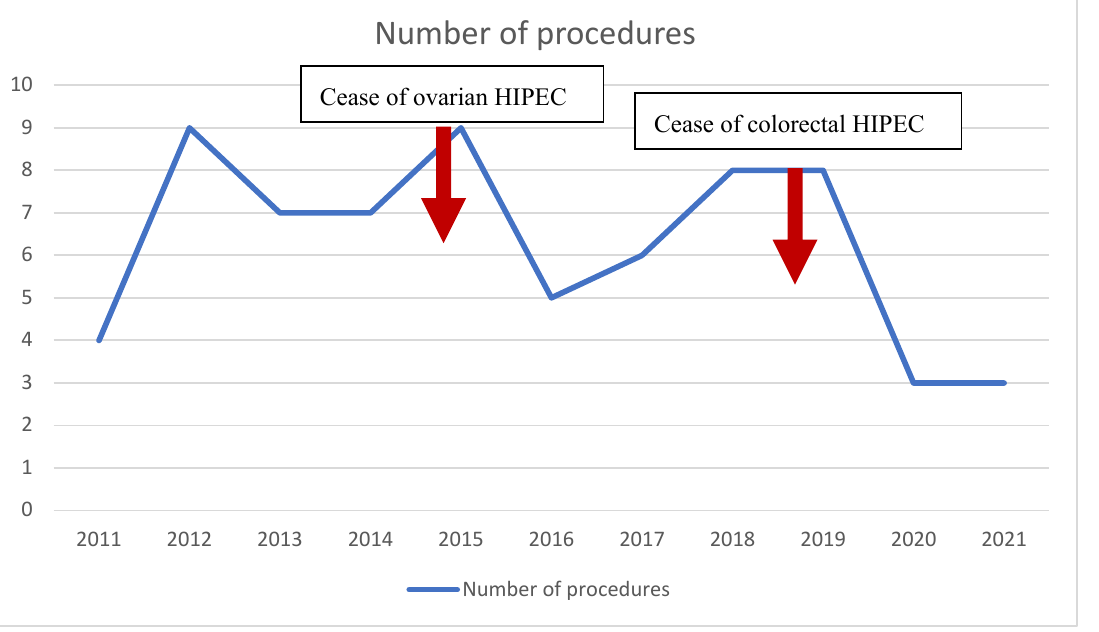
Figure 2. The annual number of cytoreductive surgery and hyperthermic intraperitoneal chemotherapy procedures throughout the study period.